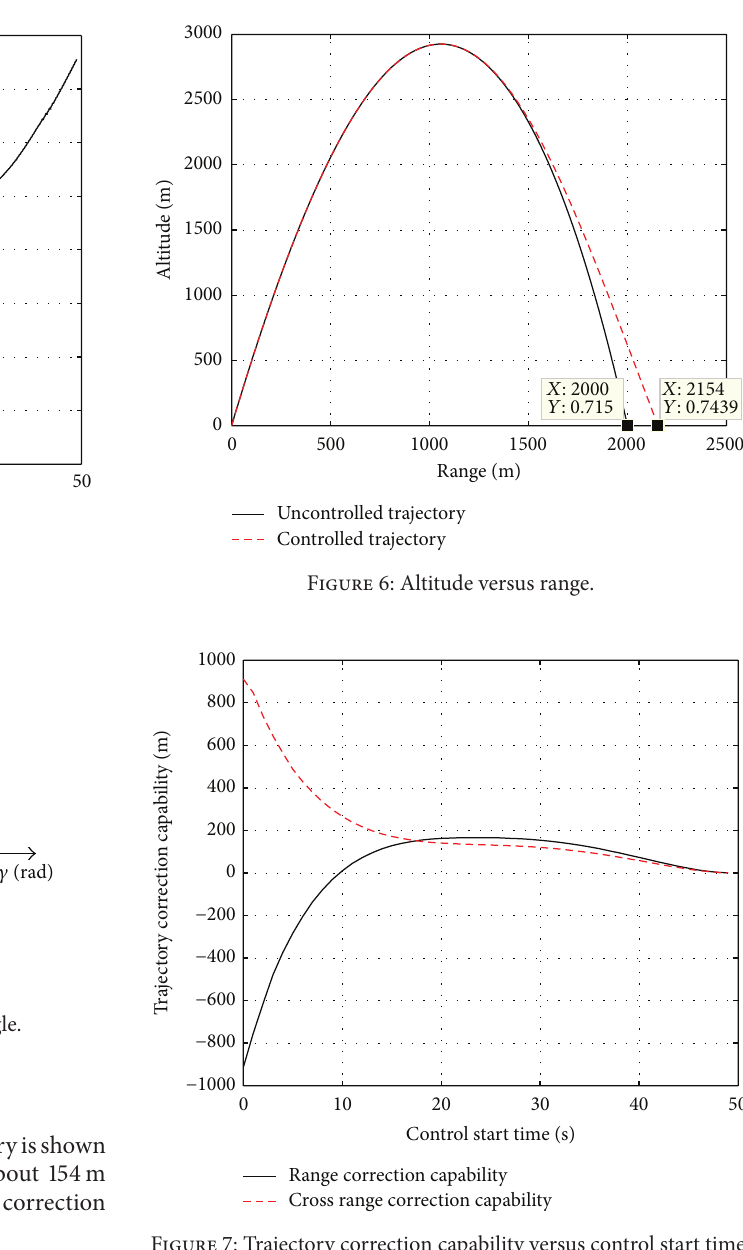
Figure 7: Trajectory correction capability versus control start